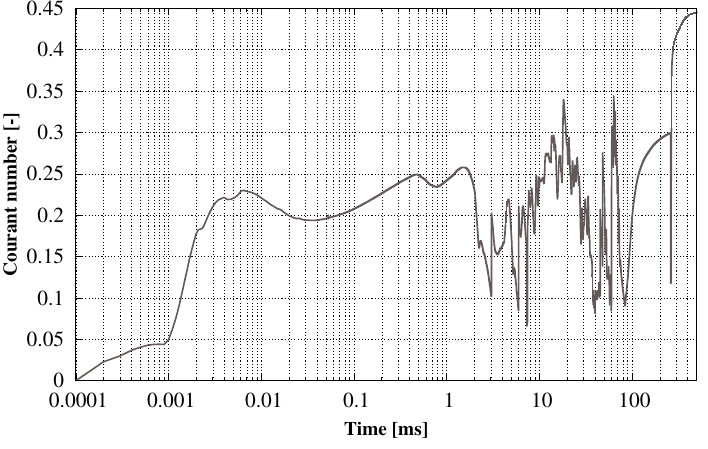
Figure 6. Courant-Friedrichs-Levy convergence condition plot during simulation